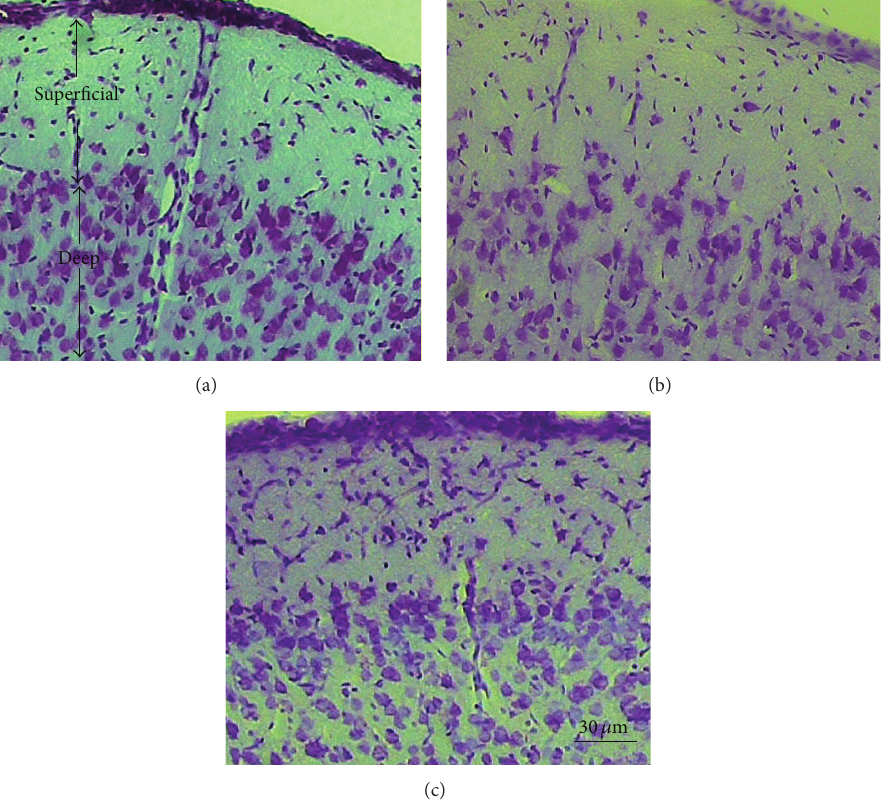
Figure 3: Photomicrograph of the mPFC in the rats. (a) Control, (b) Al-treated, and (c) Al + PIO-treated groups. The difference between the cells population in the superficial and deep layers of the cortex can be observed in the